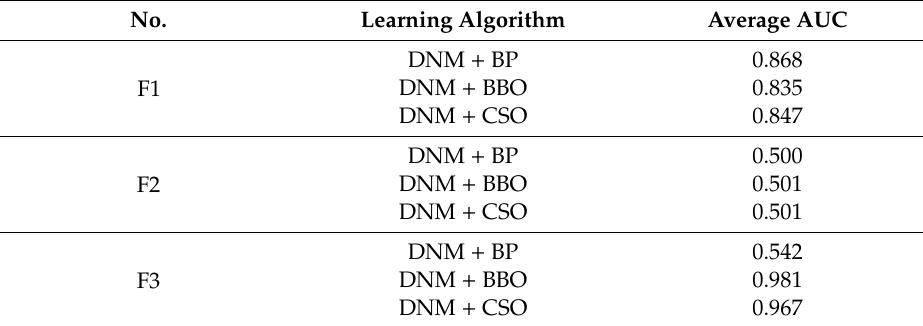
Figure 11. ROC of each method in F3. Table 18. Average area under curve (AUC) for each problem and